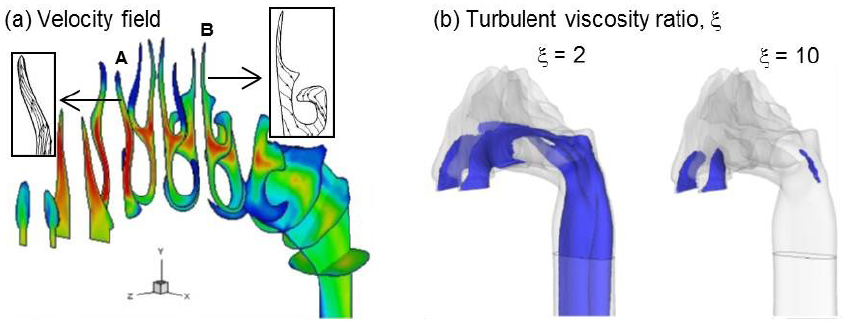
Figure 3. Inhalation airflow inside the nasal airway under normal breathing conditions: ( a ) velocity field; ( b ) turbulent viscosity ratio; ( c ) streamlines (right passage); and ( d ) flow pattern visualized with mass-less fluid particles at various